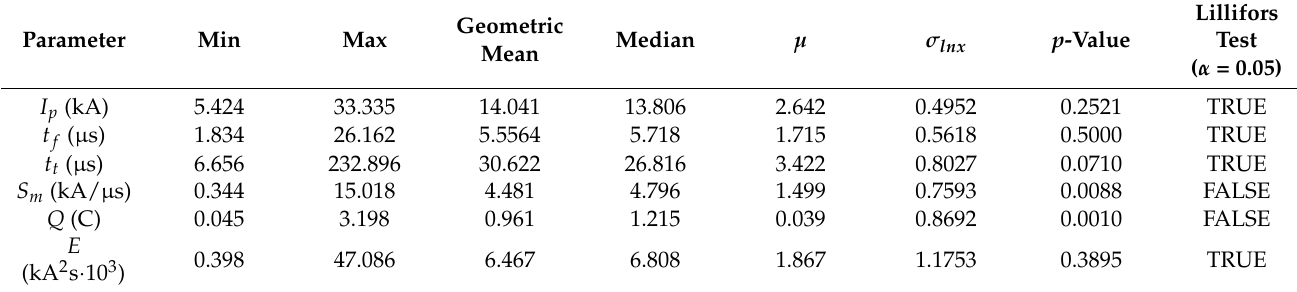
Table 5. Statistical parameters of measured first negative strokes values.